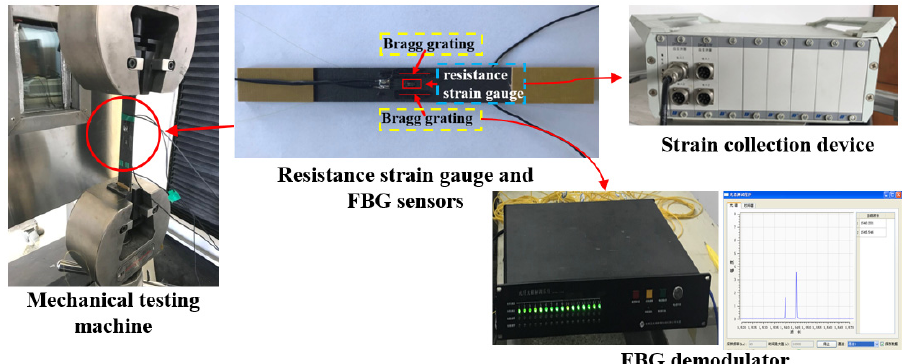
Figure 2. Resistance strain gauge and FBG sensors.